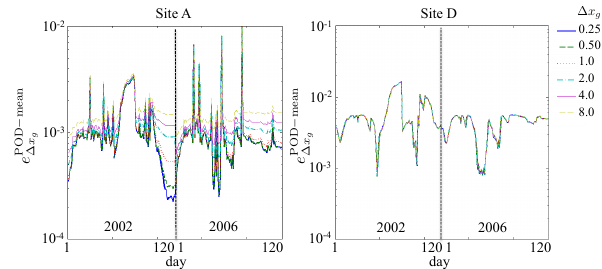
) at sites A and D in years 1x g